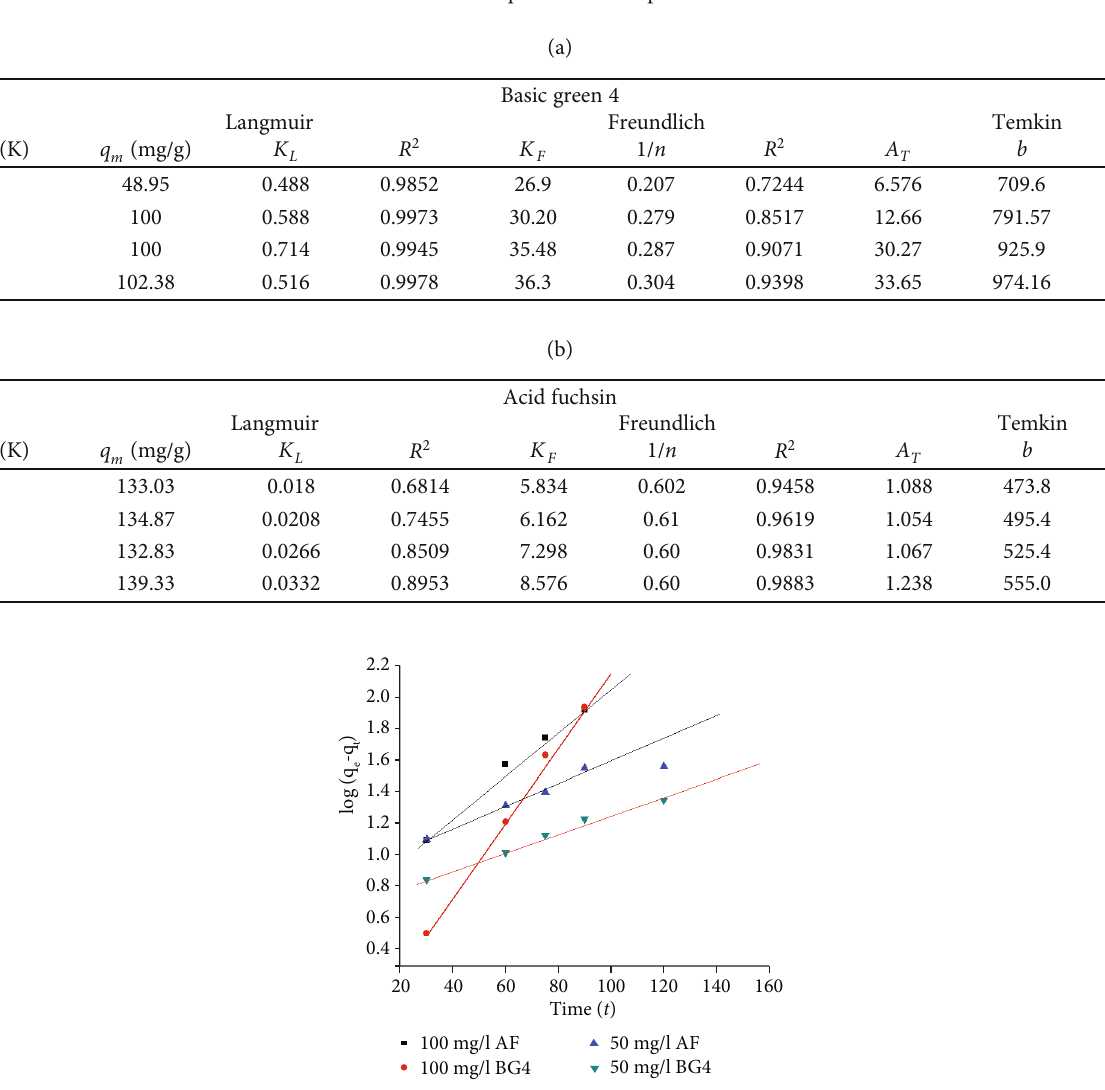
Table 3: Adsorption isotherm parameters.